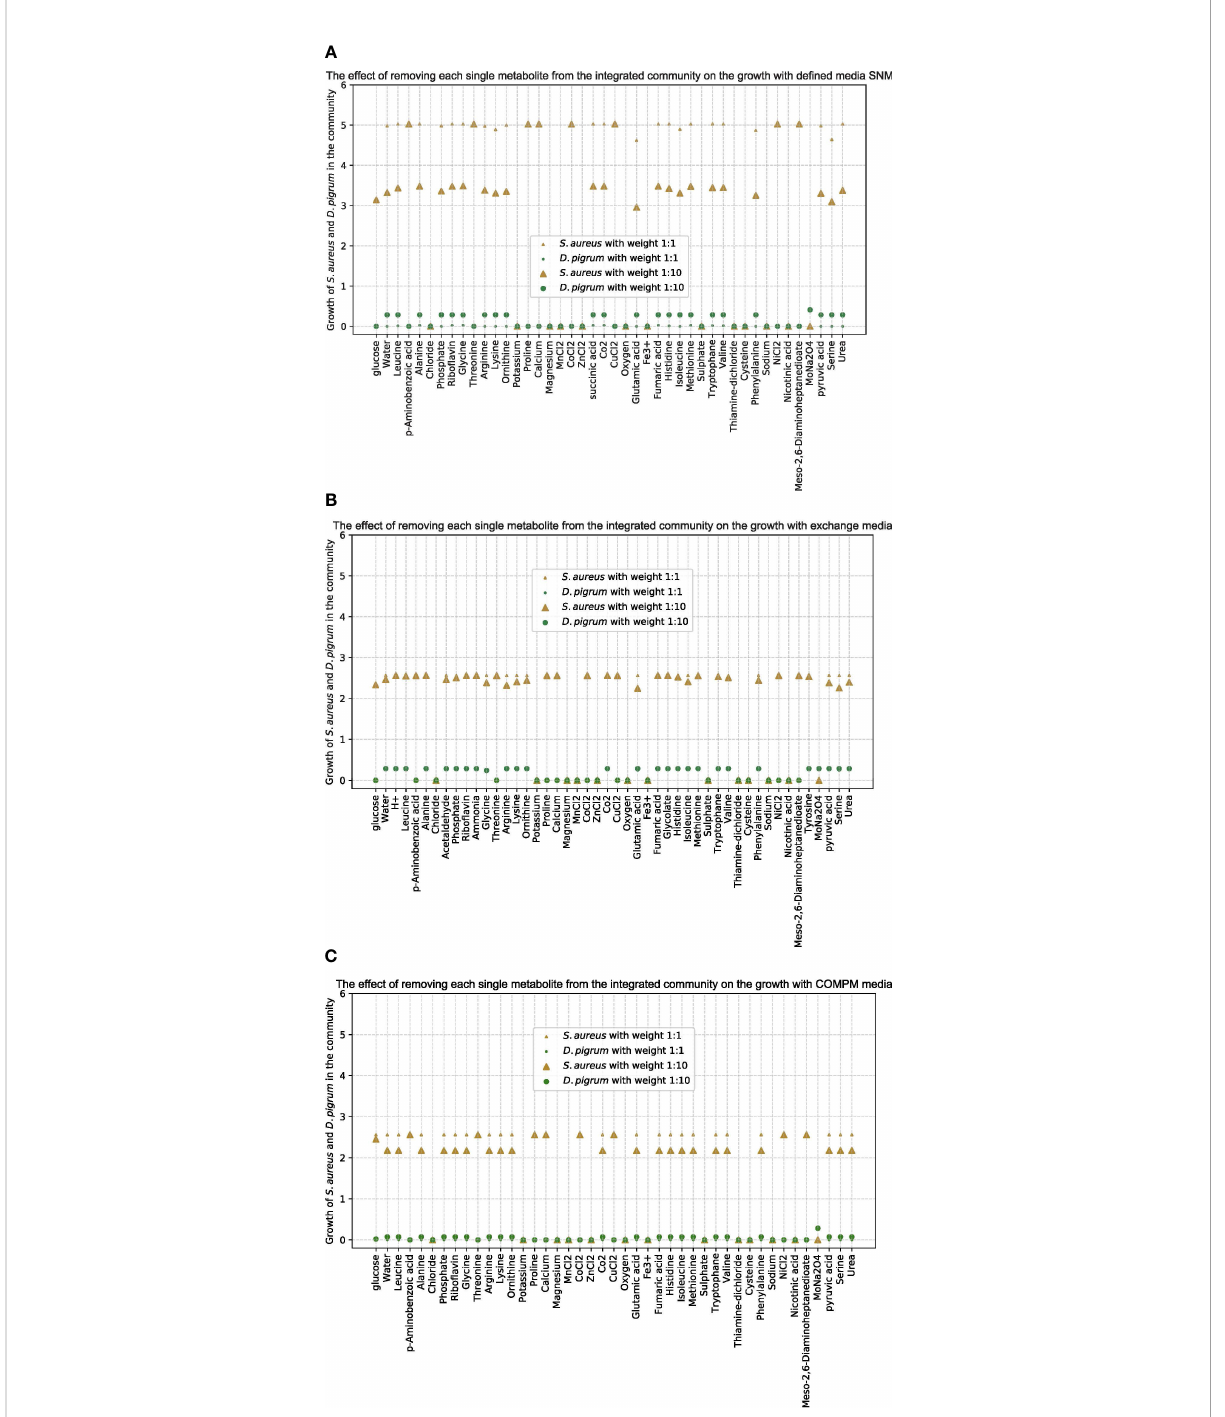
FIGURE 3 The effect of removing each single metabolite from the community by the integrated model on the growth of species D. pigrum and S. aureus as few different media implemented. (A) Is for the de fi ned SNM3. (B) Is when the medium is de fi ned as exchanges computed by FVA. (C) Is for COMPM de fi ned. The objective function in the community is de fi ned as a liner combination of the growth of both species. With all different media, once the weights in the objective function are assumed equally as 1:1 and one more time as 10:1 for D. pigrum : S. aureus. The small ◦ and △ are for the 1:1 ratio in the objective function and big ◦ and △ are for the 10:1 ratio. The gold color represents the growth of S. aureus in the community by the integrated model and the green one is for D. pigrum . The x -scale shows the metabolites in the de fi ned medium and the y -scale shows the growth of each species in the community by the integrated